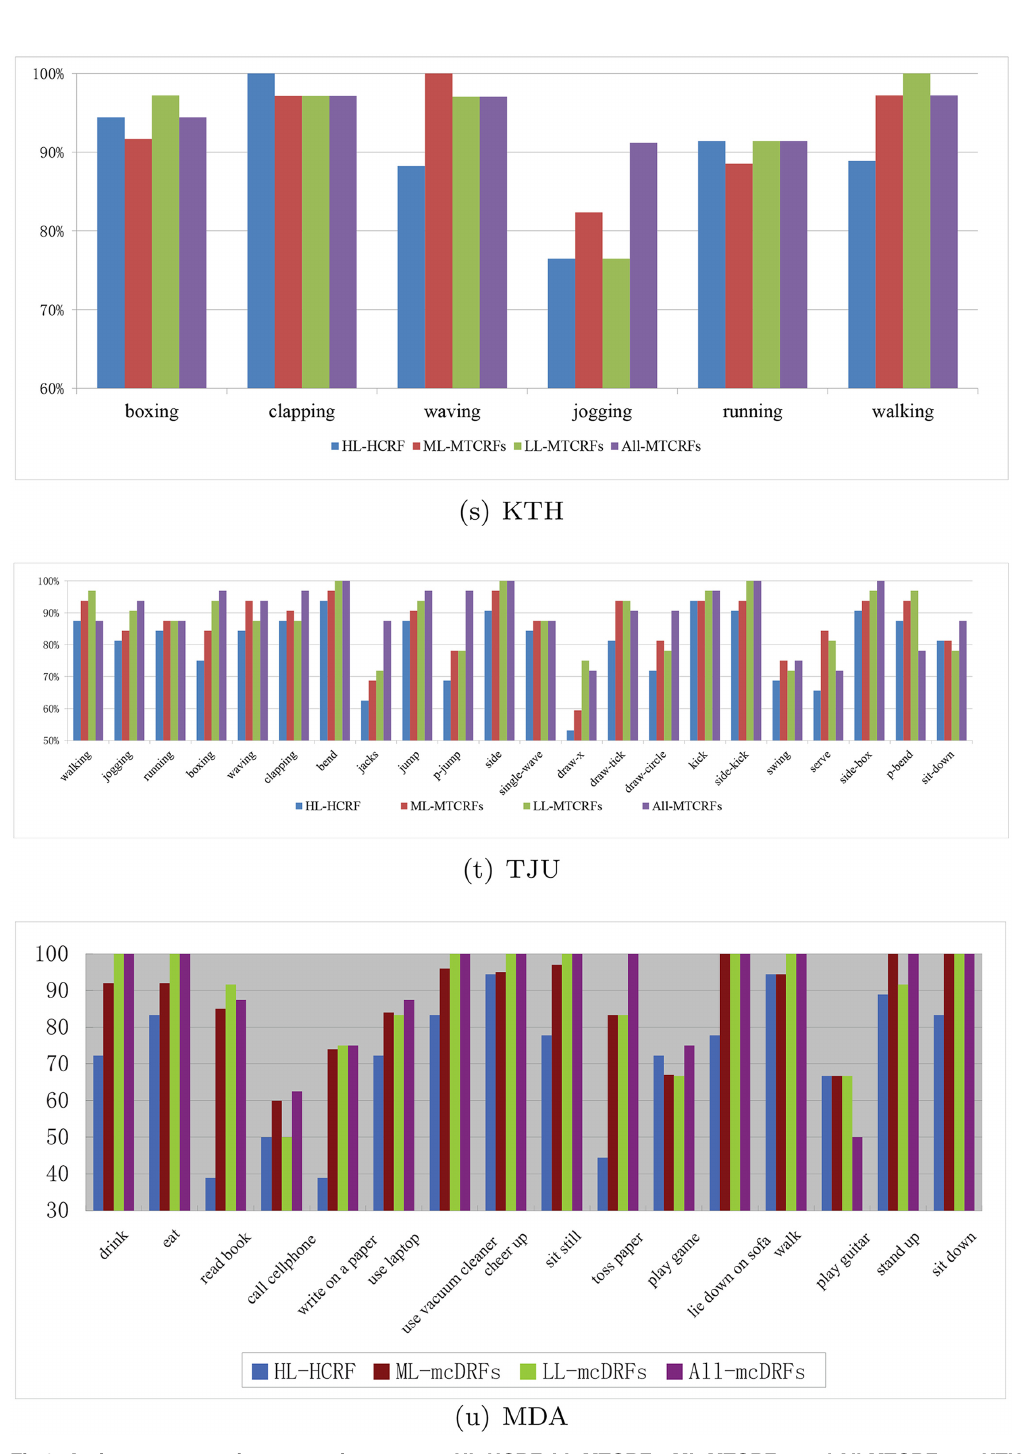
Fig 8. Action category-wise comparison among HL-HCRF, LL-MTCRFs, ML-MTCRFs, and All-MTCRFs on KTH, TJU, and MDA.